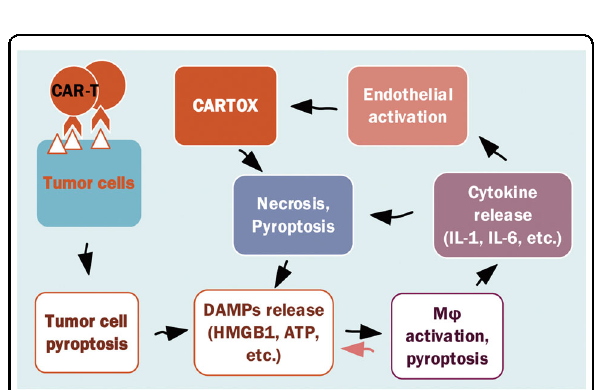
Fig. 2 Proposed pathomechanism of CARTOX. CAR-T cells recognize and trigger tumor cells in pyroptosis. Pyroptotic cells release large amounts of DAMPs, which activate macrophages (M φ ) with subsequent cytokine release, resulting in endothelial activation and CARTOX. High levels of cytokines impair other cell functions and even cause necrosis or pyroptosis, further increase DAMPs leakage, which forms a vicious circle that leads to more severe CARTOX. In addition, DAMPs, such as HMGB1, could be endocytosed and induce macrophage pyroptosis, further increasing DAMPs release and exacerbating